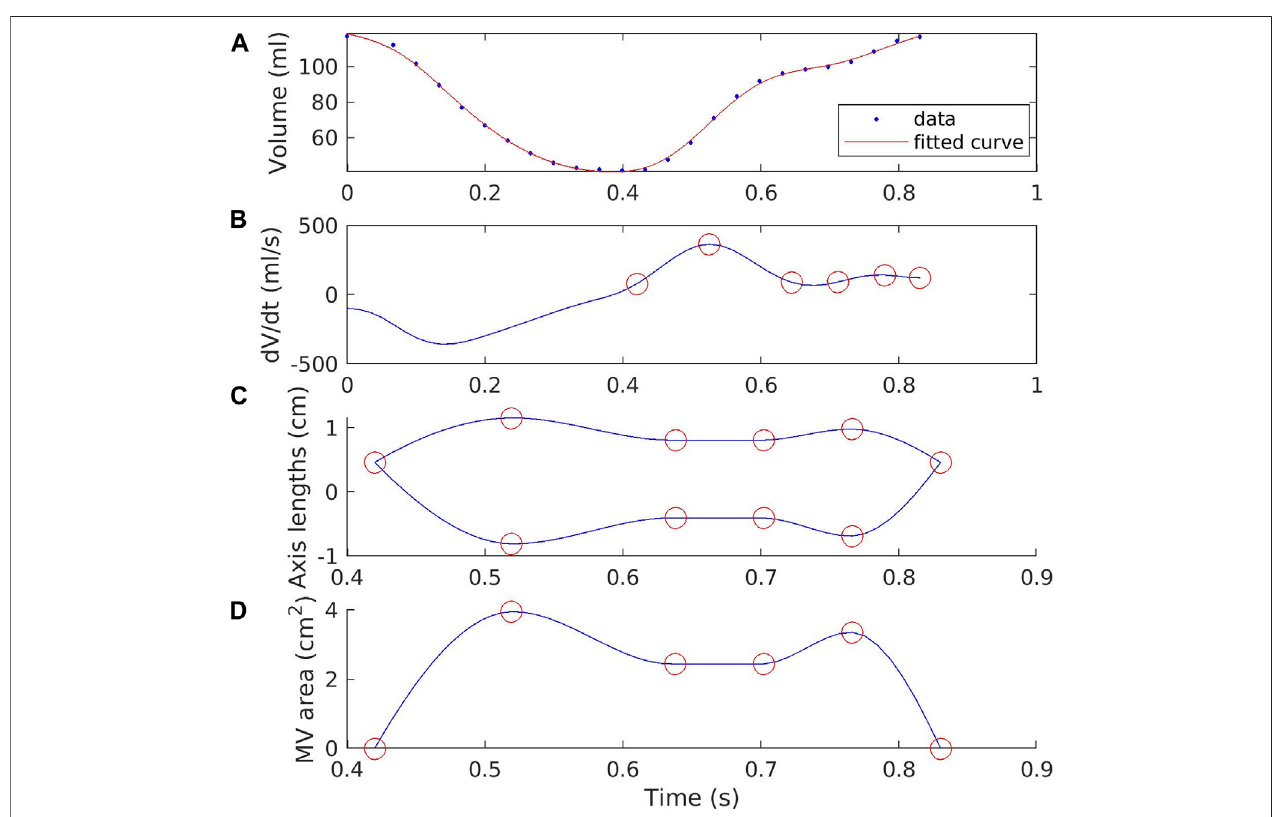
FIGURE 2 | Volume of the acquired surface meshes of the LV, and the derivative of the interpolated curve. (A) shows the volumes of the 25 used frames directly fromtheTEEimagesasbluedots,andacubicinterpolationoftheseasared line. (B) showsthe fi rstderivative, andtheresultingtimingsfromlefttorightofdiastolestart, E-wavepeak,diastasisstartandend,A-wavepeak,anddiastoleendasredcircles(see Table1 forexactvalues). (C) showsthelengthsoftheshortaxesofthelea fl etsin theMVmodelovertime,withtheredcirclesmarkingthesameinstantsasin (B) . (D) showstheresultingMVopeningareaindiastolefortheuntreatedMV,againwith red circles denoting the same timings. Note that the time scale in (C) and (D) only covers diastole, since the MV is closed in systole. The exact times and scalings of the short axes are given in Table 1 .